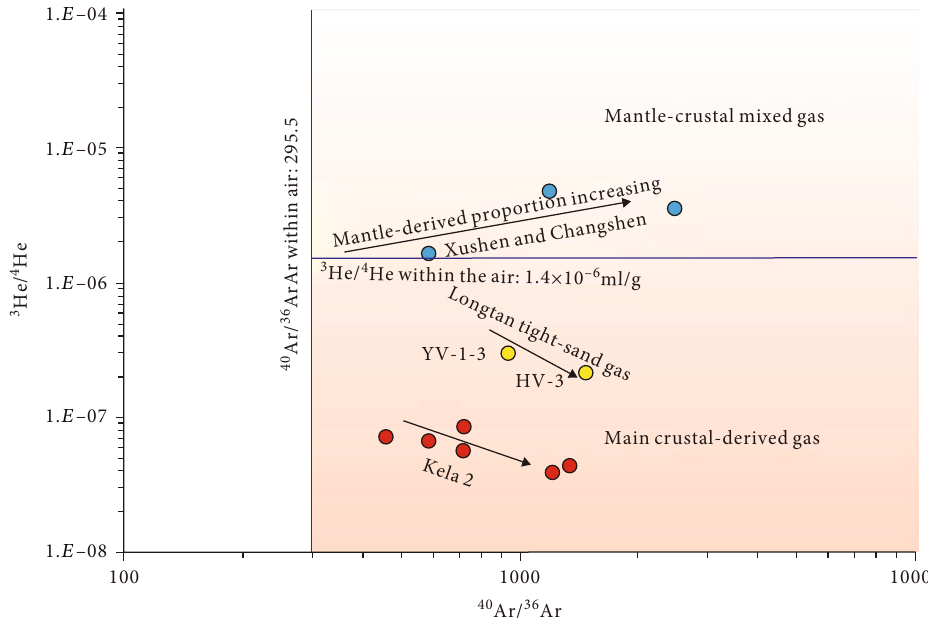
Figure 10: Crossplots of 40 Ar/ 36 Ar versus 3 He/ 4 He of typical gas fi elds in China and Longtan tight sand gas in west Guizhou, showing that the Longtan 40 Ar/ 36 Ar values decrease with 3 He/ 4 He values. The data of Kela2, Xushen, and Changshen are from Wang et al. 0.187, respectively, which are close to that in the air at 0.188 (Table 4). The drastic di ff erences in the isotopic ratios (e.g., 4 He/ 20 Ne) among the samples and the air indicates that the compositions of tight gas samples are hardly in fl uenced by those isotopic ratios in the air.